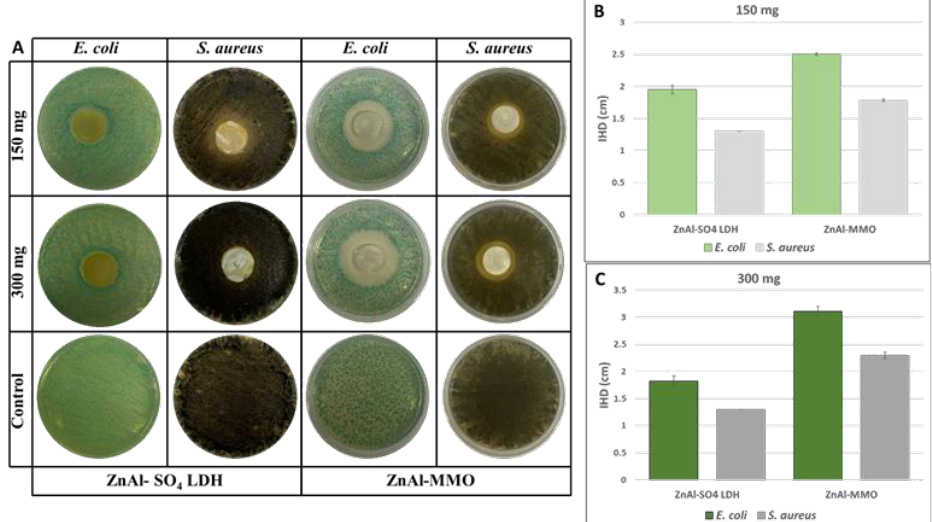
Figure 4. ( A ) E. coli and S. aureus images obtained after incubation in the presence and absence of ZnAlSO 4 -LDH and ZnAl-MMO. Inhibition halo diameters (IDHs) of ZnAlSO 4 -LDH and ZnAl-MMO samples obtained with ( B ) 150 mg and ( C ) 300 mg.